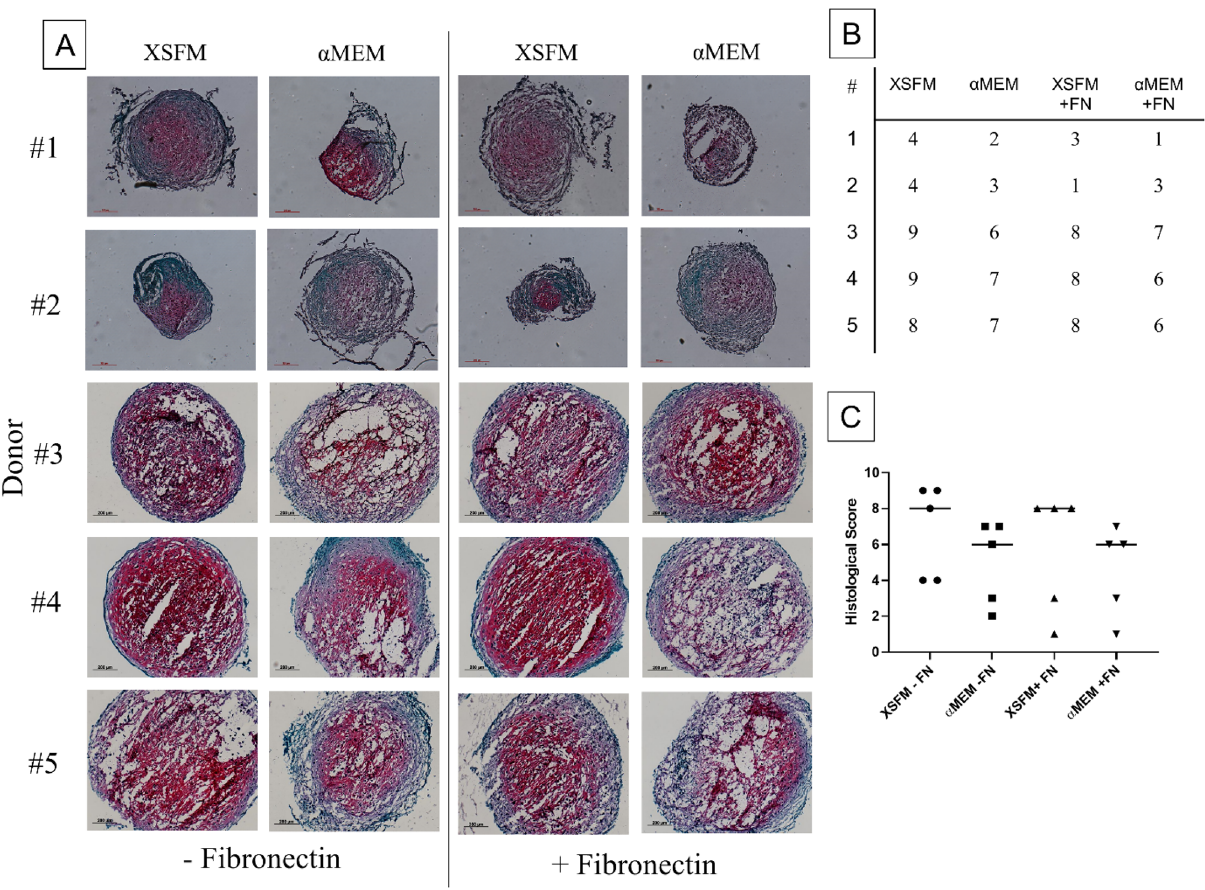
Figure 5. Analysis of the chondrogenic potential of BMSCs expanded in different cell culture media (n = 5 donors). ( A ) Representative images of pellet cryosections stained by Safranin-O/Fast Green: the intensity of Safranin-O (red) staining is directly proportional to the extracellular proteoglycan content, while Fast Green solution (green) stains collagen fibers. Scale bar (bottom left in each picture) = 200 µm. ( B ) The table indicates the histological score assigned to each pellet (1- undifferentiated; 10- very good differentiation). Grading of the safranin O staining was ranked on a scale of 1–10 according to the Bern Score 24 . ( C ) Comparison of the histological scores among the groups for all